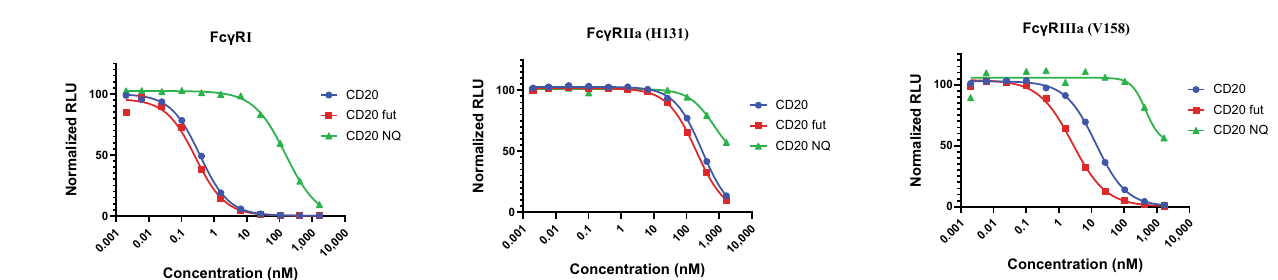
Figure 3. Dose dependent inhibition curves generated with six different FcγR assays. Four different set of samples were tested to show the specificity and subclass specific binding. Analytes tested are (1) human IgG subclasses IgG1, IgG2, IgG3, IgG4; (2) human IgG; (3) Fc, Fab, and F(ab) 2 domains; and (4) human serum albumin (HSA). Data represent the mean ± standard error of triplicate experiments. IC 50 (nM) values calculated from the inhibition curves are shown in the Table. IC 50 values are in nM. *For FcγRIIb IC 50 values are intended only for qualitative purposes as mentioned in the text. n.d. not determined.